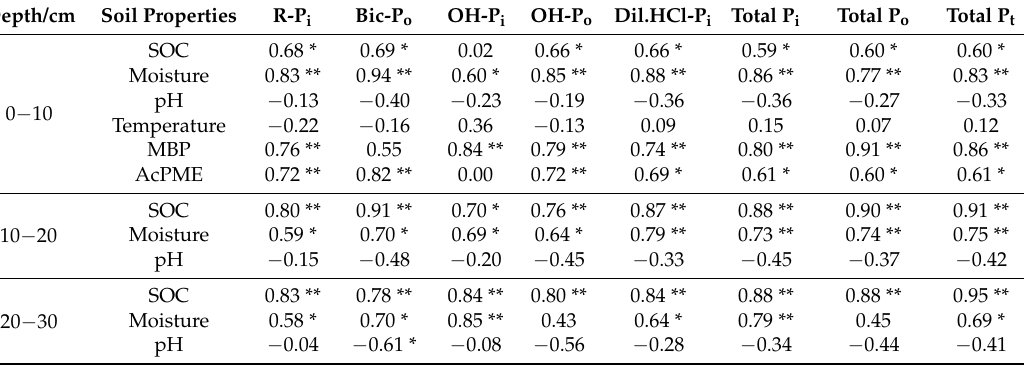
Table 4. Coefficient (r) for the pearson’s correlations between soil P fractions and soil property in L. principis-rupprechtii